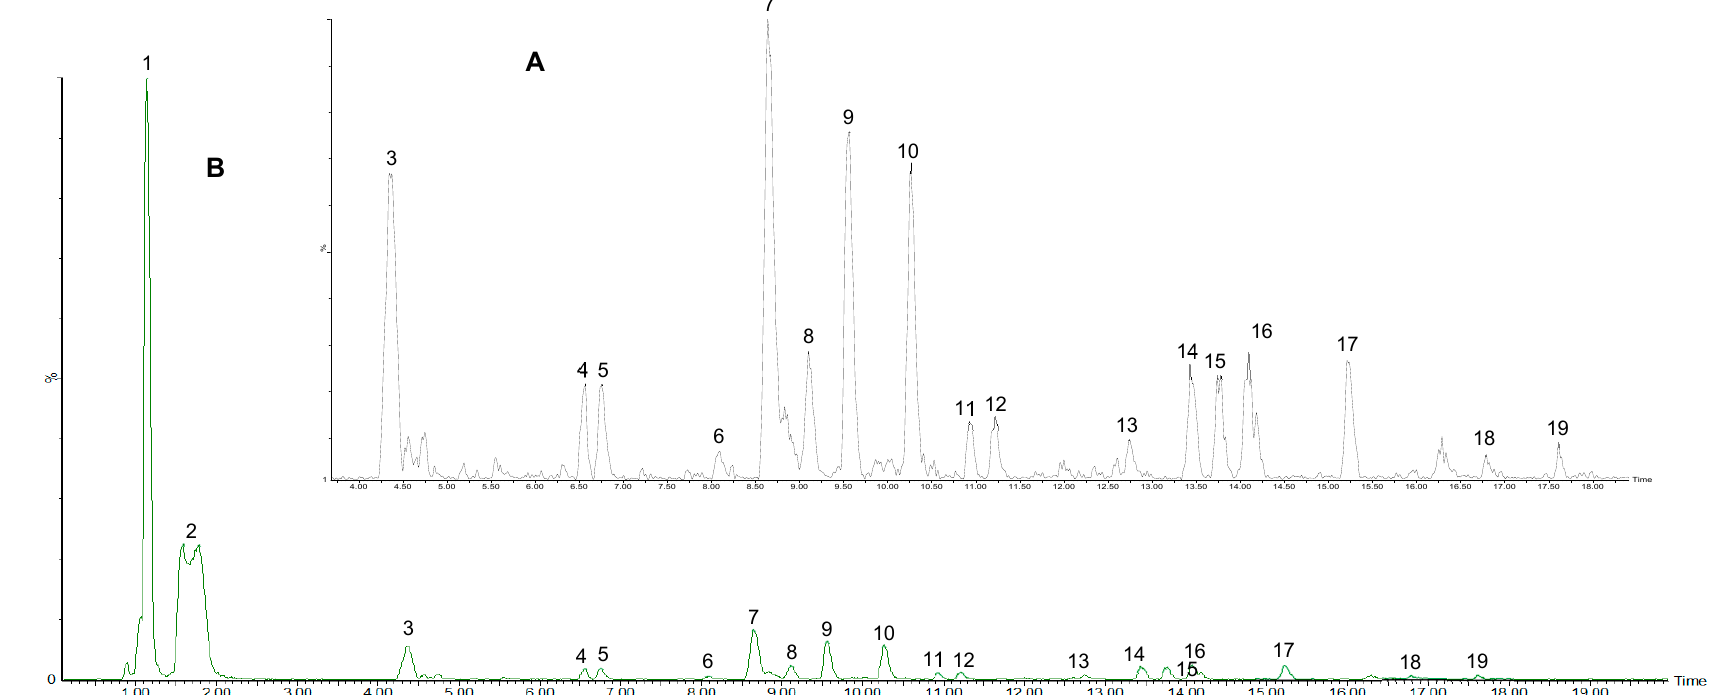
Figure 3. TIC chromatograms of Carissa edulis fruit samples at ripening stage 1. ( A ) Zoomed in chromatogram > 4 min; ( B ) full chromatogram.